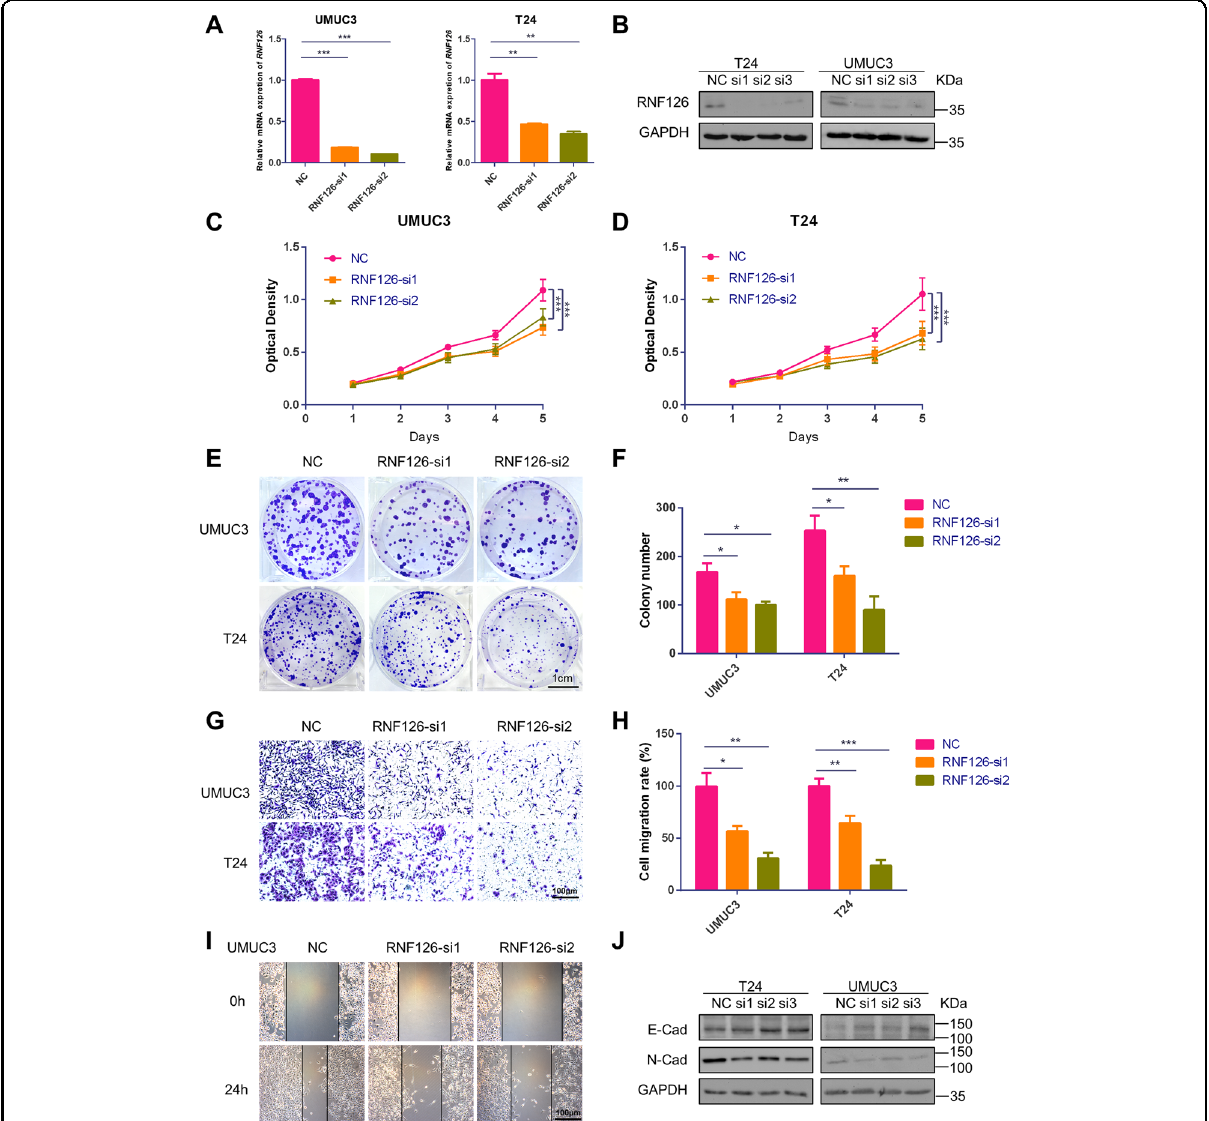
Fig. 2 Depletion of RNF126 inhibited BCa cell proliferation, migration, and viability. A The qRT-PCR veri fi ed the ef fi ciency of knockdown RNF126 by siRNA (RNF126-si1 and RNF126-si2) in two BCa cells T24 and UMUC3. B The western blotting veri fi ed the expression of RNF126 downregulation in T24 and UMUC3 cells after transfection with the RNF126 siRNA. The internal control was GAPDH abundance. C, D The MTT assay evaluated the T24 and UMUC3 cells growth and viability from day 1 until day 5 after transfection with the RNF126 -si1 and si2 (orange line and green line). E The colony formation assay showed the effect of RNF126 knockdown on the cell survival of UMUC3 and T24 cells after the transfection. Scale bar = 1 cm. F Colony numbers were counted and plotted as indicated. G The transwell assay evaluated cell migration of the RNF126 -si1, si2 and NC treated BCa cells. Scale bar = 100 µm. H The number of cell migration was counted and statistically analyzed. I The wound healing assay evaluated the migration of siRNF126 -treated BCa cells after scratching for 24 h. Scale bar = 100 µm. J The western blotting revealed the downregulation of protein abundance of EMT markers (E-Cad, N-Cad) in the BCa by reduction of RNF126. GAPDH severed as control. *** p < 0.001, ** p < 0.01, * p <